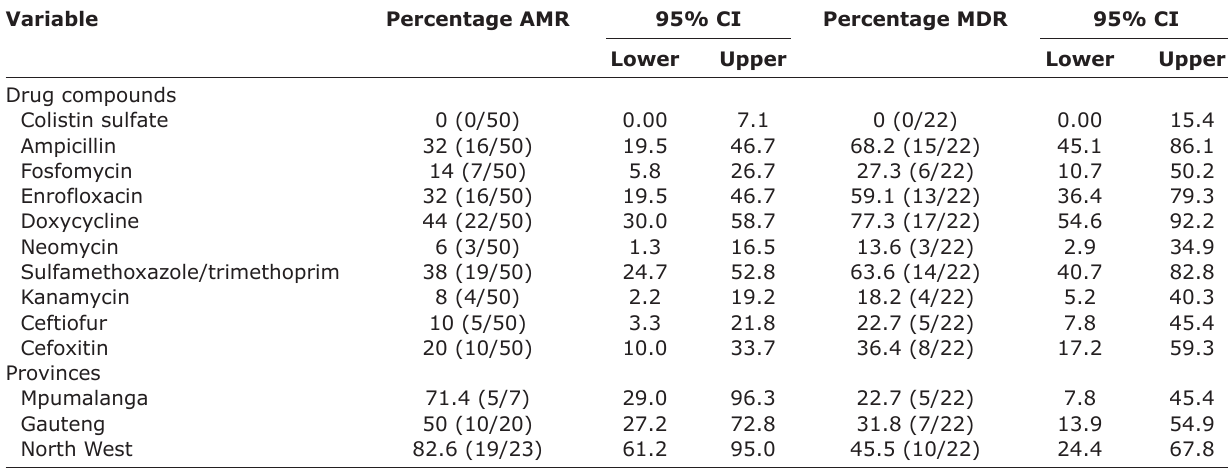
Table-1: Proportions of AMR in clinical Avian E. coli isolates, obtained from South Africa in 2016. Variable